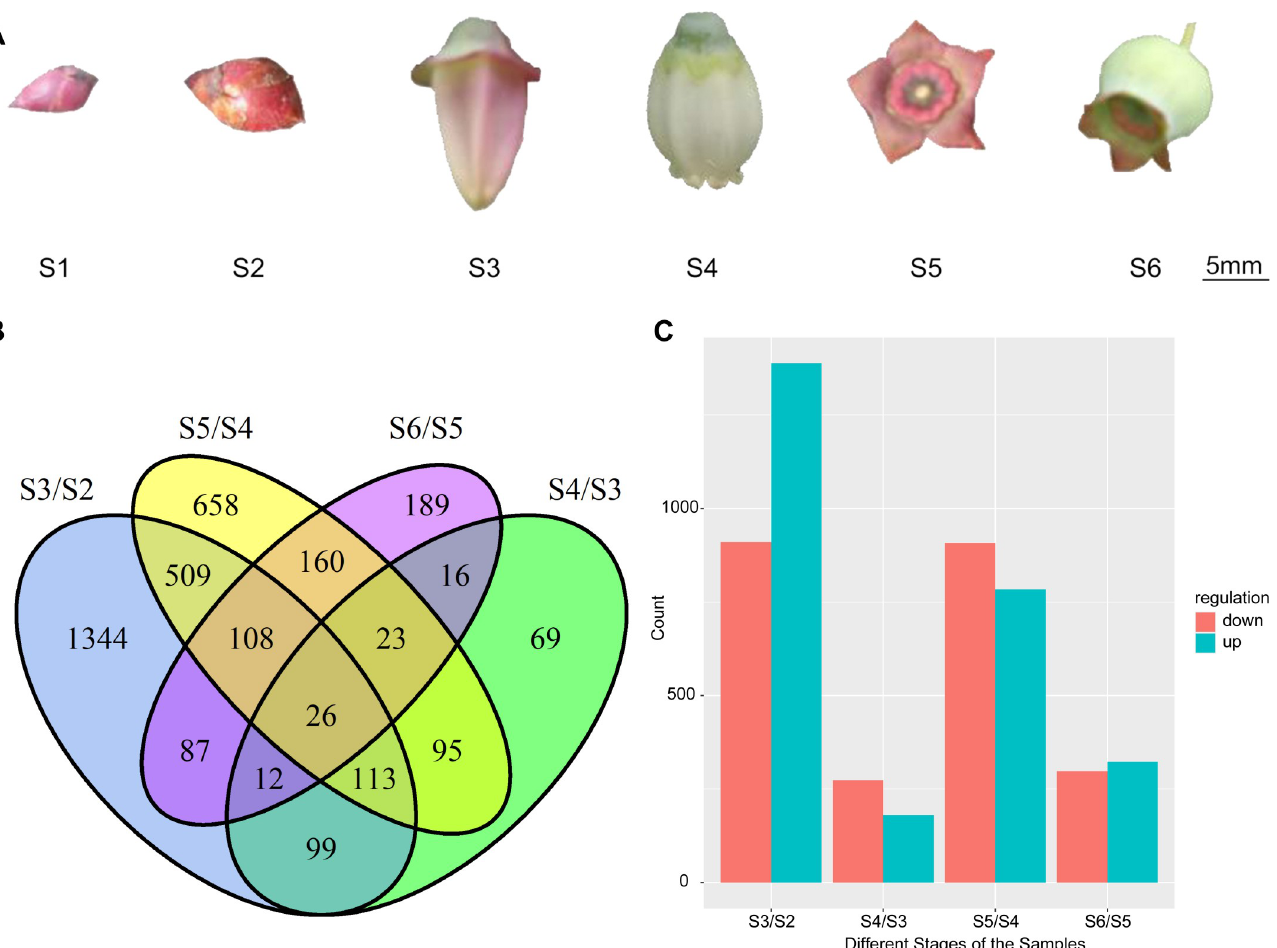
Fig 1. Analysis of Differentially Expressed Genes (DEGs) between each library pair. (A) Samples of Vaccinium ashei for RNA-seq. S1, leaf bud; S2, flower bud; S3, initial flower; S4, bloom flower; S5, pad fruit; S6, cup fruit. (B) Venn diagram of the DEGs in comparisons of five samples (numbers in circles represent the numbers of DEGs in different stages). (C) Numbers of up-regulated (up) and down-regulated (down) genes in the comparisons of five samples.